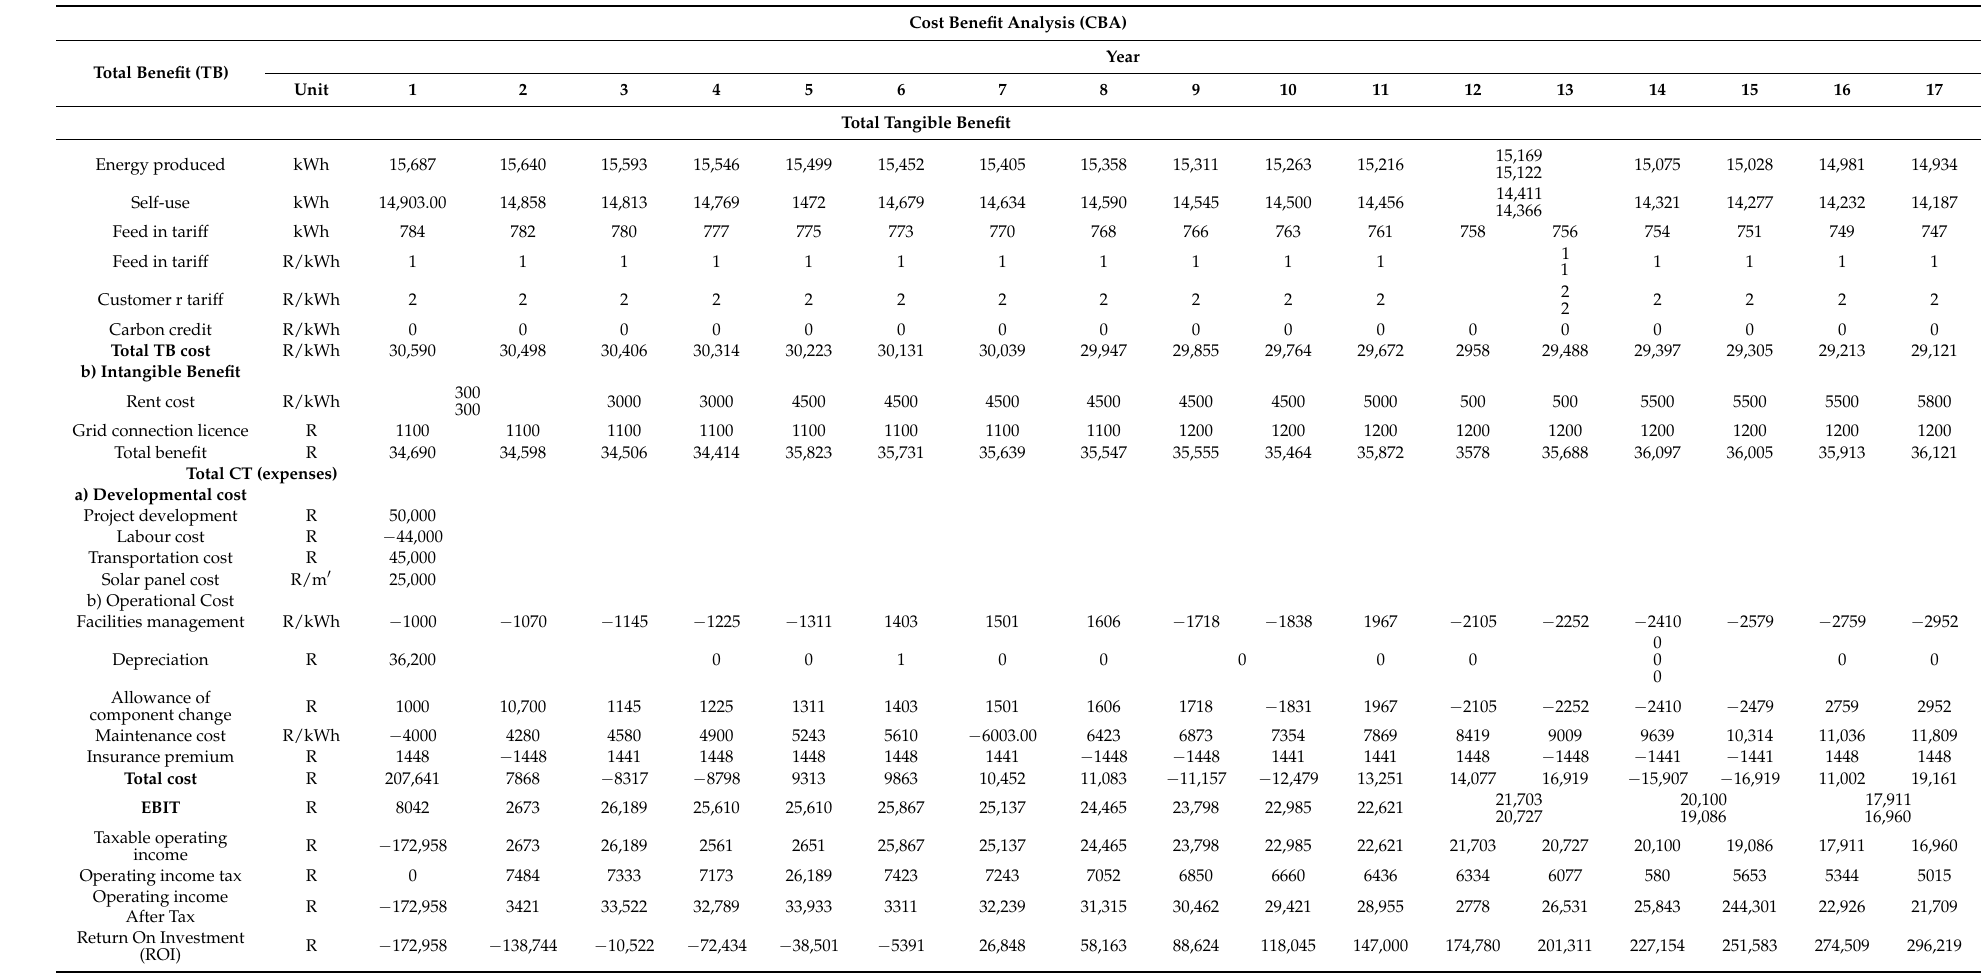
Table 3. Cost Benefit Analysis (CBA) for solar energy in eThekwini